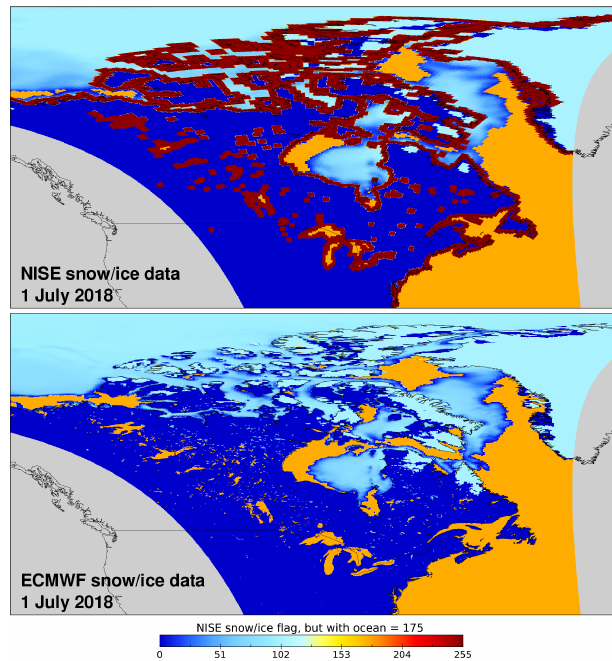
Figure 9. Snow/ice flag comparison for the ground pixels of orbits 03707 and 03708 of 1 July 2018 based on NISE (top panel) and ECMWF (bottom panel) snow/ice cover data. The NISE coding for the flags is used, except that “ocean” is coloured with orange (value 175) instead of red for its flag value 255 so as to clearly distinguish it from the flags 252 (mixed pixels at coastlines), 253 (suspect ice value) and 254 (error); the latter three do not occur in the ECMWF data. Other flag meanings are 0: snow-free land, 1–100: percentage sea ice, 101: permanent ice, and 103: snow. The depicted area is longitude [ − 140 to − 40 ◦ ], latitude [ + 35 to + 85 ◦